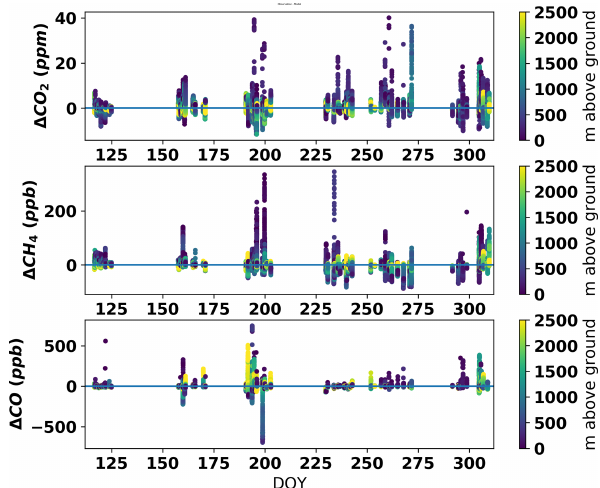
Figure 9. Observation–model differences in mole fractions below 3000ma.s.l. Corrections have been made for observation–model offsets above 3000ma.s.l. (Fig. 7). Colors show the altitude of each deviation. Dark blue indicates differences near the surface, while yellow indicates differences near